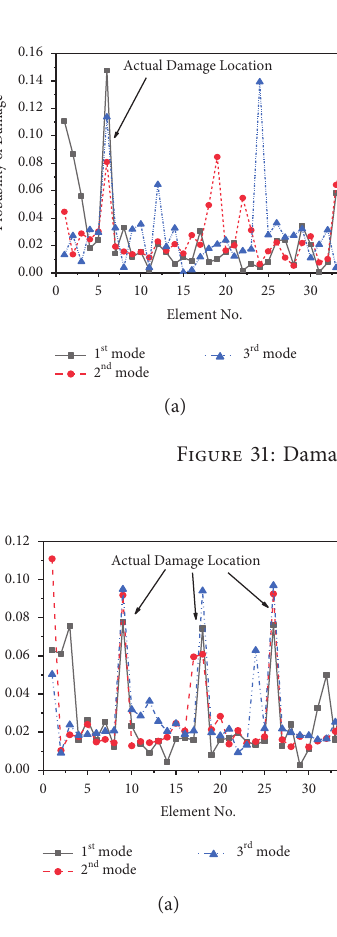
Figure 32: Damage identification results of form 4 for DR (a), CR (b), and RD